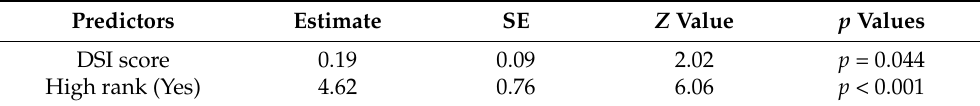
Table 4. The results of the GLMM to determine the factors that affect agonistic support of Tibetan macaques.